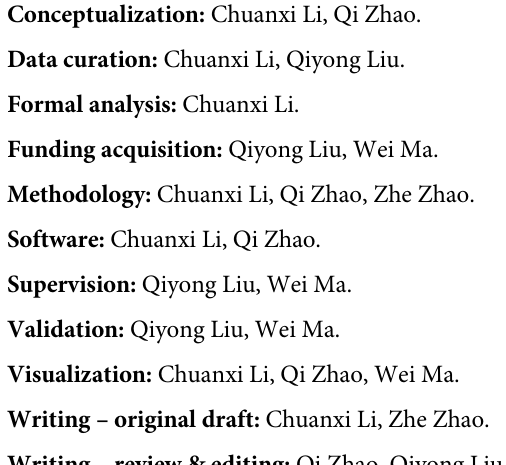
S1 Fig. Daily precipitation and number of DF cases in study periods of each tropical cyclone in the PRD from 2013 to 2018. S2 Fig. Sensitivity analysis of the association between tropical cyclones and DF incidence on lag 5–14 days by using principal component analysis (PCA). S3 Fig. Sensitivity analysis of the association between tropical cyclones and DF incidence on lag 5–14 days by changing meteorological variables. Model I: original model; Model II: excluding RF; Model III: excluding EWV. S1 Table. Spearman correlation coefficients of tropical cyclone intensities and meteorolog- ical variables. S2 Table. Components extraction and total variance explained.